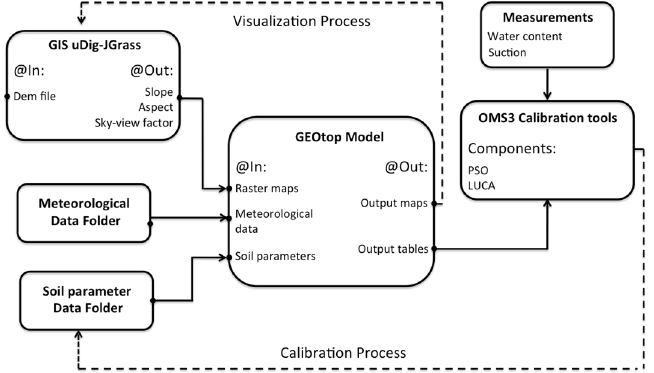
Figure 3. The GEOtop model is integrated in the OMS framework, as represented in this schematic flow chart. The uDig JGrass GIS is used to create the input raster maps and visualize the output (Visualization Process). Moreover, GEOtop can use the automatic calibration algorithms implemented in OMS. Parameters such as soil hydraulic parameters can be optimized to reproduce measurement data using Particle Swarm Optimization (PSO) or LUCa (based on the Shuffle Complex Evolution method).